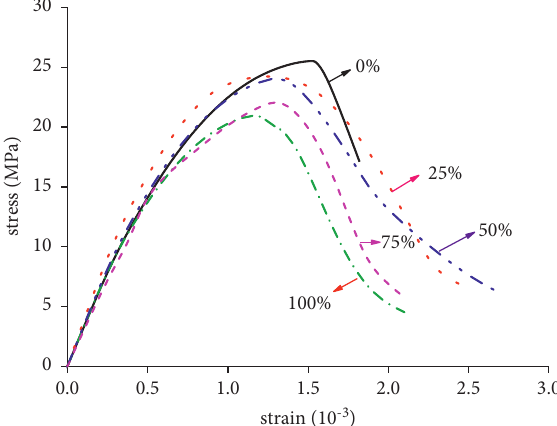
Figure 5: Stress-strain curves of recycled lightweight aggregate